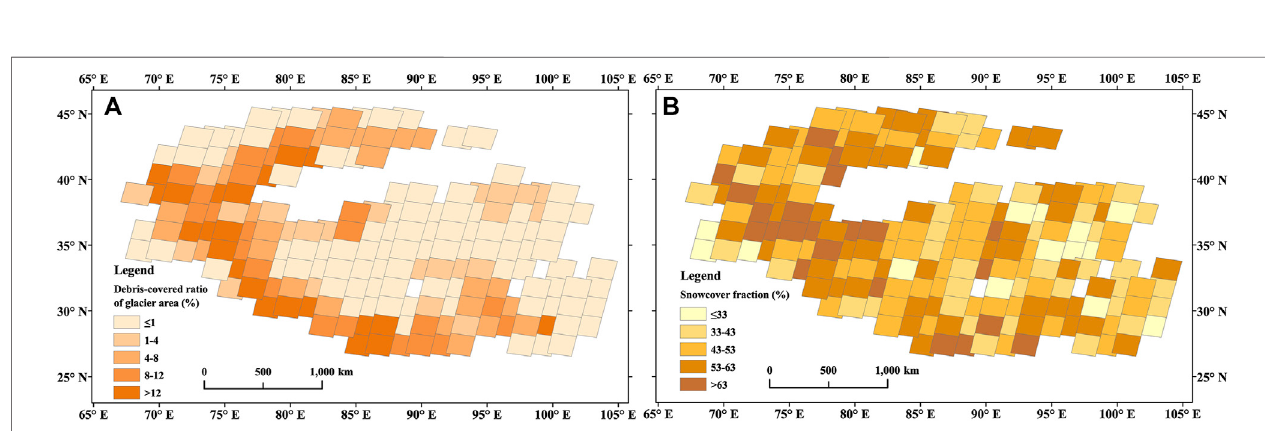
FIGURE 3 | Comprehensive quality-grading results of the eight glacier inventories (Grades 1 to 4 represent high to low quality). See Table 1 for the abbreviations.